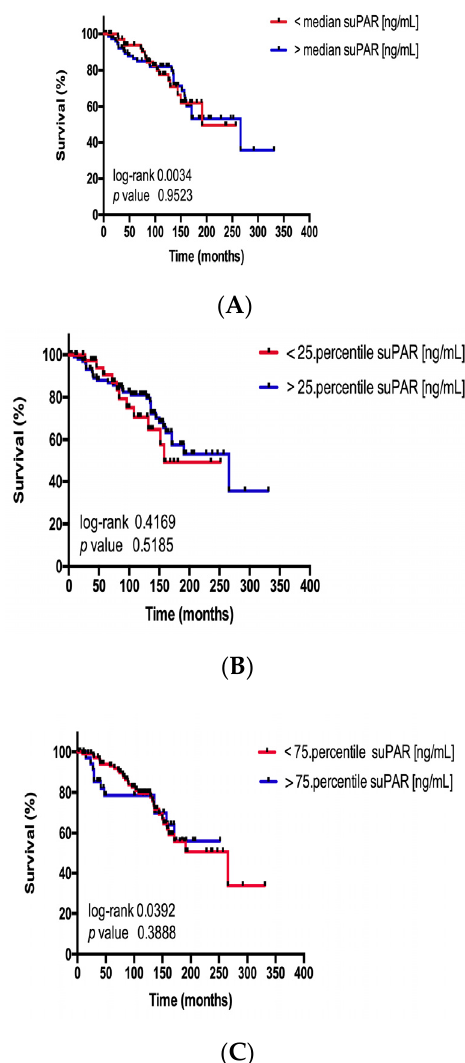
Figure 4. suPAR serum levels are not associated with the patients’ prognosis. Kaplan–Meier analysis of serum suPAR levels above (red curve) and below (blue curve) the ( A ) median (2.31 ng/mL), ( B ) the 25th percentile (1.58 ng/mL) and ( C ) 75th percentile (3.46 ng/mL) show a similar overall survival. Consequently, the median, 25th and 75th percentile are not appropriate cut-off values of suPAR serum levels to discriminate between patients with a good or poor long-term prognosis.